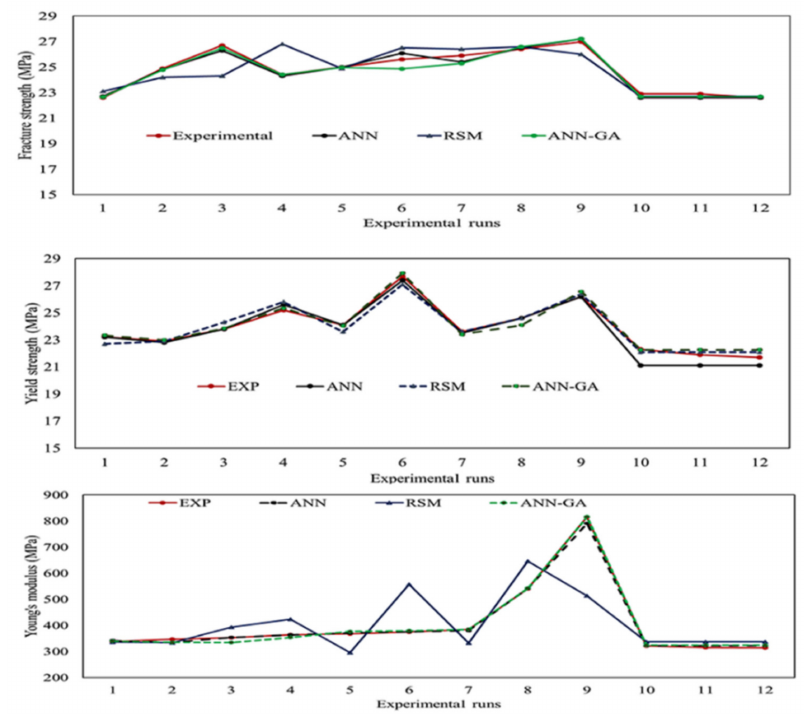
Figure 14. Comparison of the outputs of the modeling techniques with the experimental